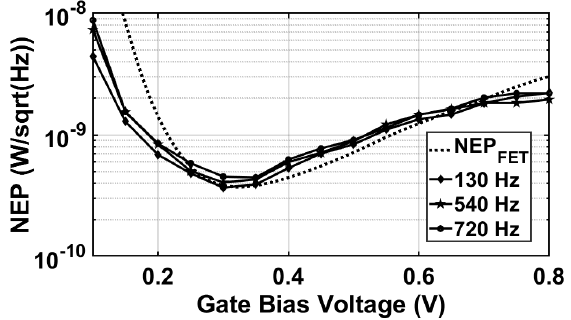
Figure 19. NEP as a function of FET gate bias voltage (measured at 365